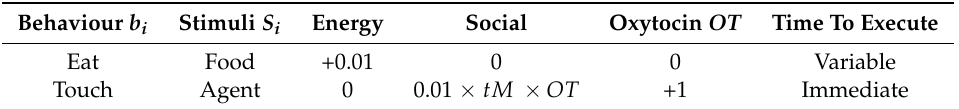
Table 1. Effects on internal variables for both consummatory behaviours that an agent can execute. tM = Touch Modulation (the amount that the Touch behaviour satisfies agent physiology) within each condition and OT = the value of endogenous Oxytocin of the agent.